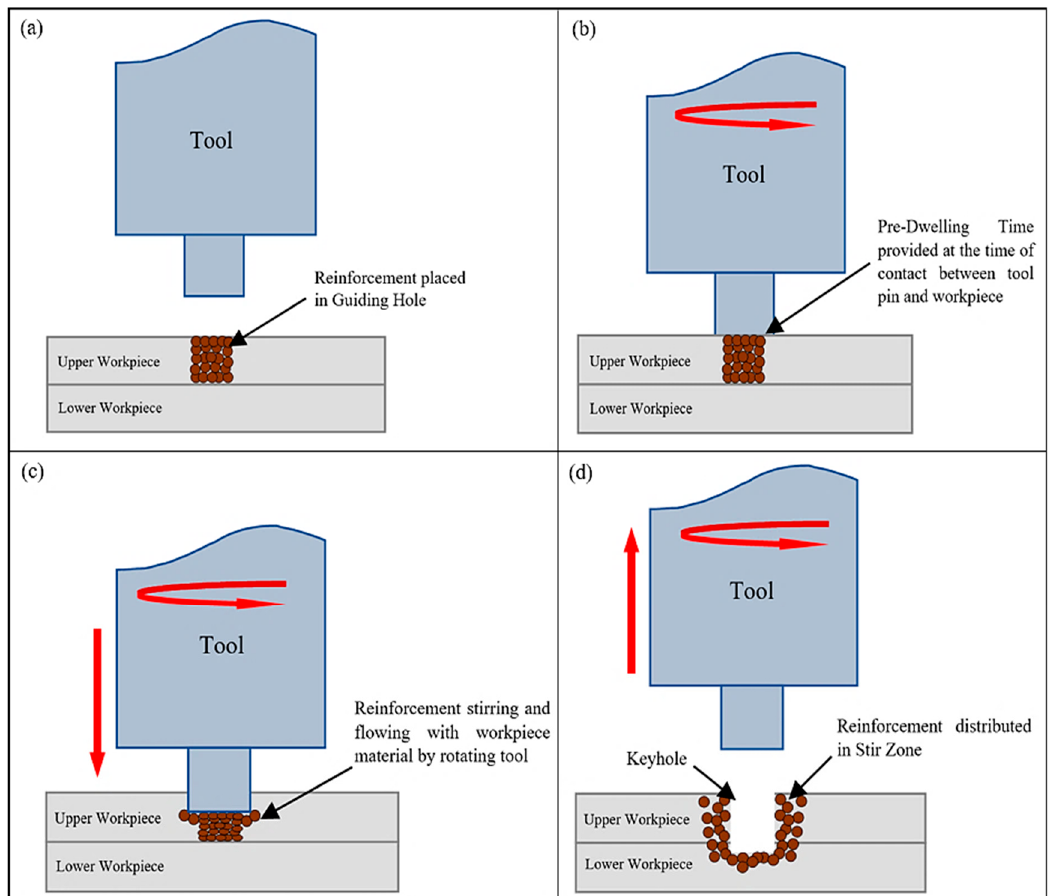
Figure 1. Schematic of the FSSW process: ( a ) placing reinforcement in a predrilled hole; ( b ) pre-dwelling time; ( c ) plunging and stirring; ( d ) retracting.